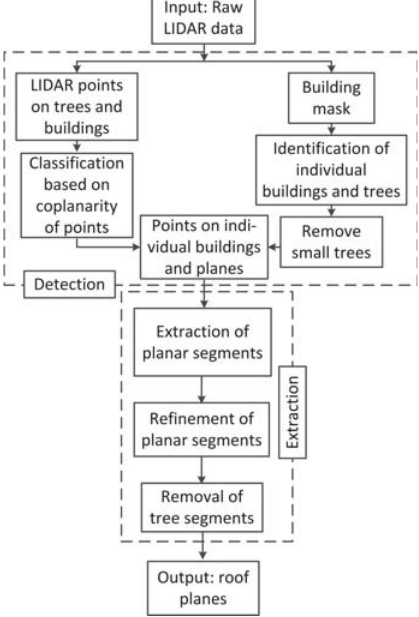
Figure 1: The proposed roof plane extraction